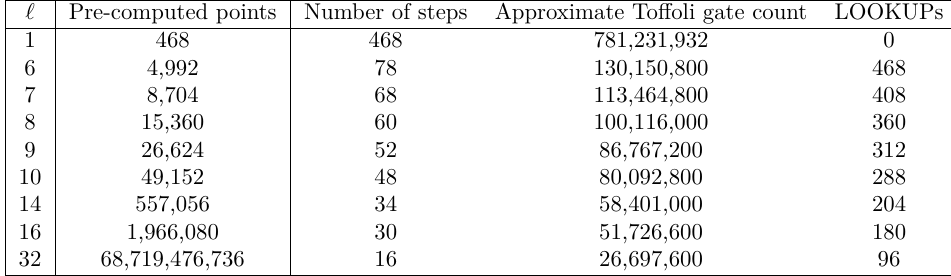
Table 4: Comparison of window sizes for n =